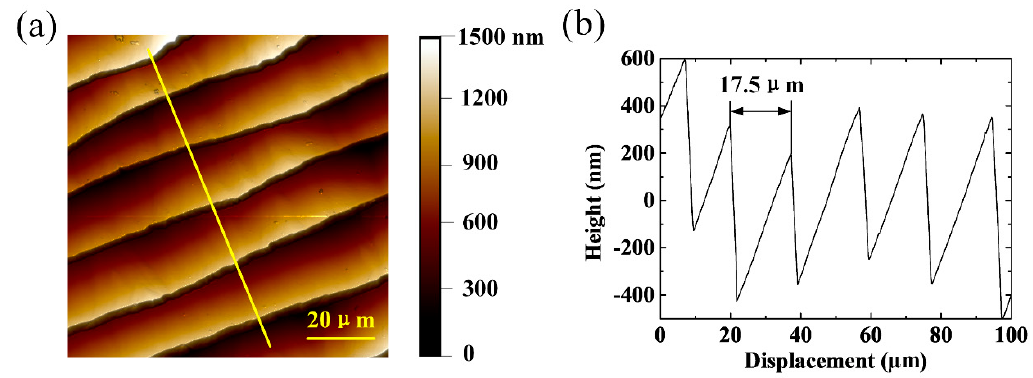
Figure 5. Atomic force microscopy (AFM) images of Sample C. ( a ) Two ‐ dimensional image of the sample surface after growth and ( b ) surface fluctuation along the yellow line in the two ‐ dimensional image.